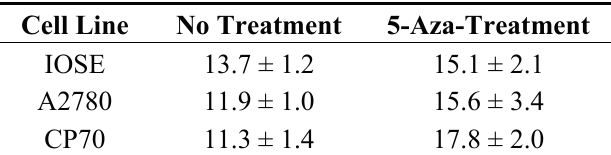
Table 2. The level of protein expression in cell lines IOSE, A2780 and CP70 determined by integration of IR signals of amide I and amide